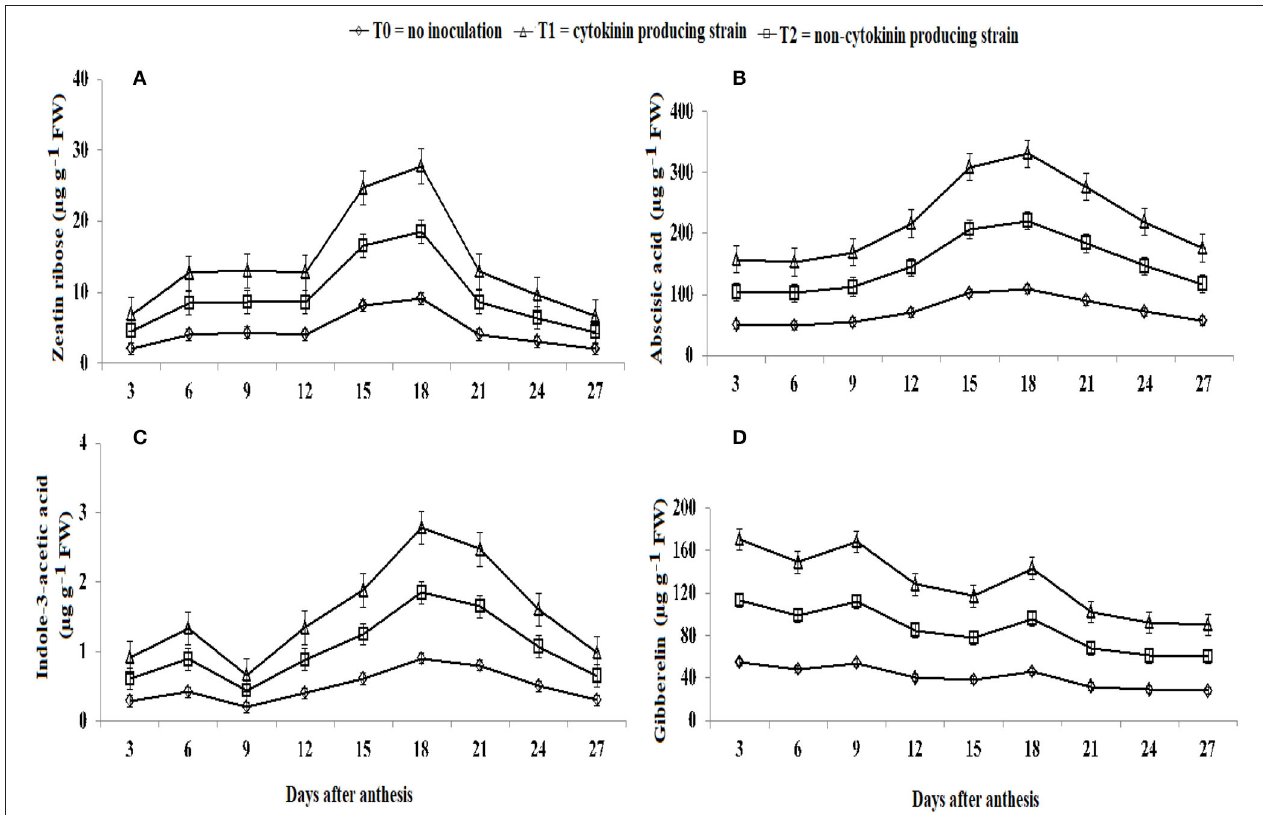
FIGURE 7 | Effect of Ck-producing A. brasilense RA − 17 and non-producing A. brasilense RA − 18 on levels of endogenous hormones ( µ g g − 1 FW) in wheat